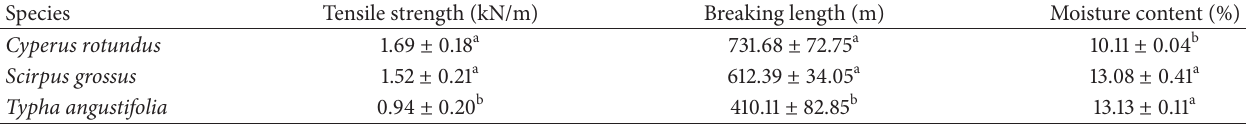
Table 4: Measurement for determination of paper quality of selected aquatic plant species.